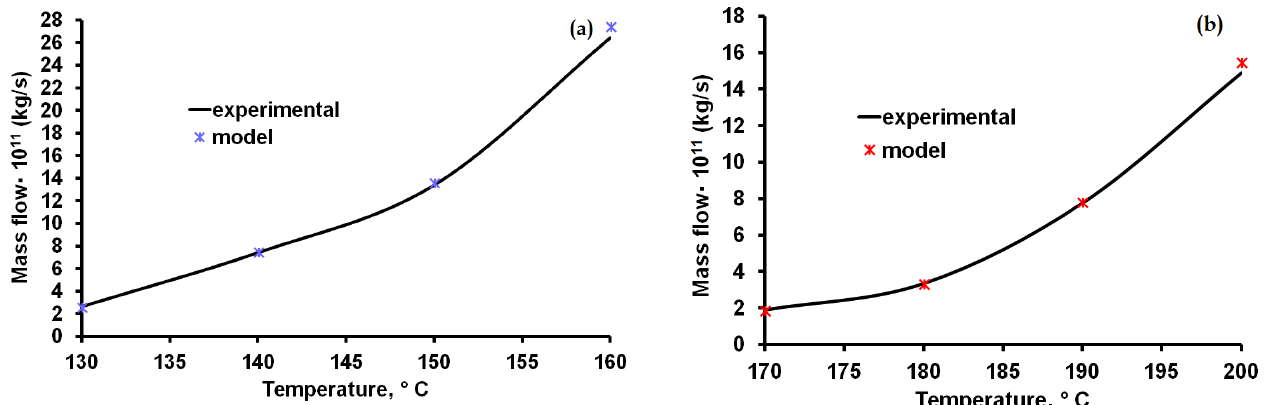
Figure 8. Influence of temperature on the mass flow of sublimated caffeine ( a ) and theophylline ( b ). Table 4. The values of coefficients a, b, c, d in the dimensionless Equation (7).